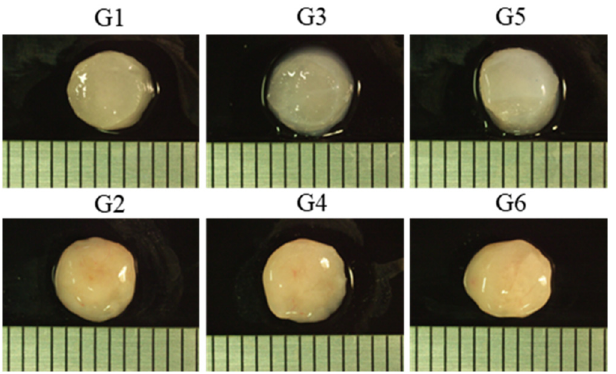
Figure 4. Gross appearances of the samples after in vitro culture for 8 weeks (G1, G3, and G5) and the samples after 4 weeks in vitro culture + 4 weeks in vivo subcutaneous implantation (G2, G4, and G6).